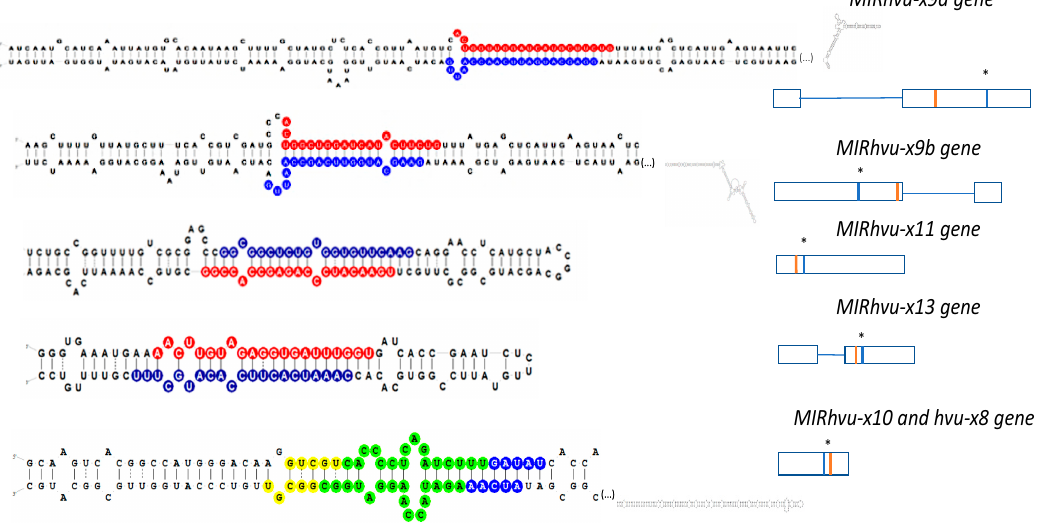
Figure 3. Schematic representation of identified novel miRNA precursors and their MIR genes. Left panel presents pre-miRNA hairpin structures of novel miRNAs. Red color indicates sequence of microRNA, the blue color indicates its corresponding microRNA*. In the case of microRNAhvu-x8 and microRNAhvu-x10 that are processed from the same precursor (microRNAhvu-x10 from 5’ arm and microRNA, hvu-x8 from 3’ arm) mature miRNAs are depicted in yellow color and miRNAs* in blue, green color indicates common nucleotides for those microRNAs and their microRNA*.Right panel shows novel MIR gene structures. White boxes represent exons while connecting thin lines indicate intronic sequences (1 cm corresponds to 100 bp). The red bar represents position of microRNA while blue bar represents position of microRNA*. Pre-miRNAs for miRNAhvu-x9a, -9b and miRNAhvu-x10 and -8 are very long. Dots in brackets represent sequence in the middle of hairpin structure that due to the length cannot be presented on the graph (full sequences are shown in Supplementary data).